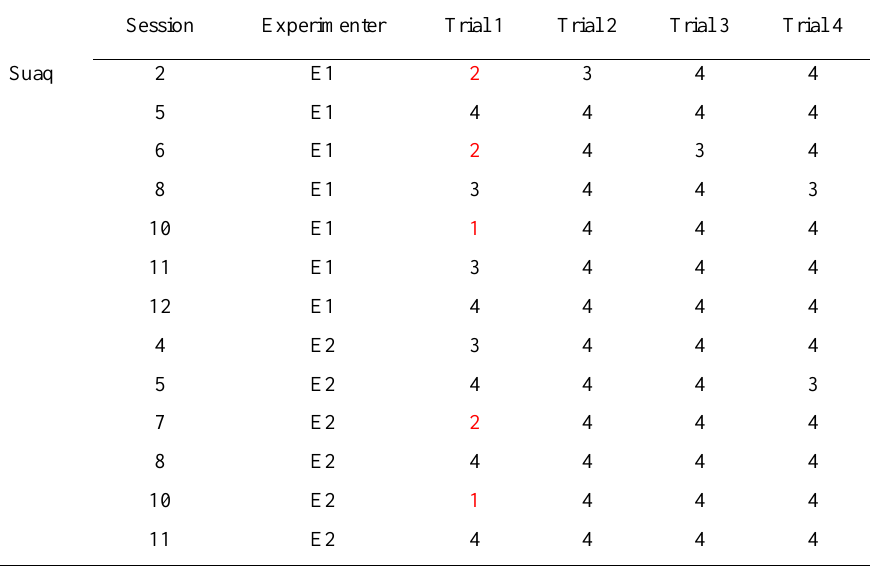
Number of Correct Exchanges in the First Four Exchanges of Each Trial, for Each Passed Session Session